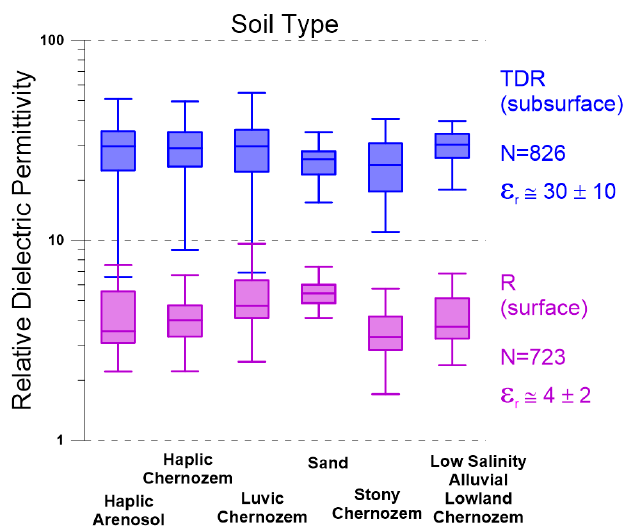
Figure 7. Field electromagnetic parameter data from six surveys transects with different lengths.